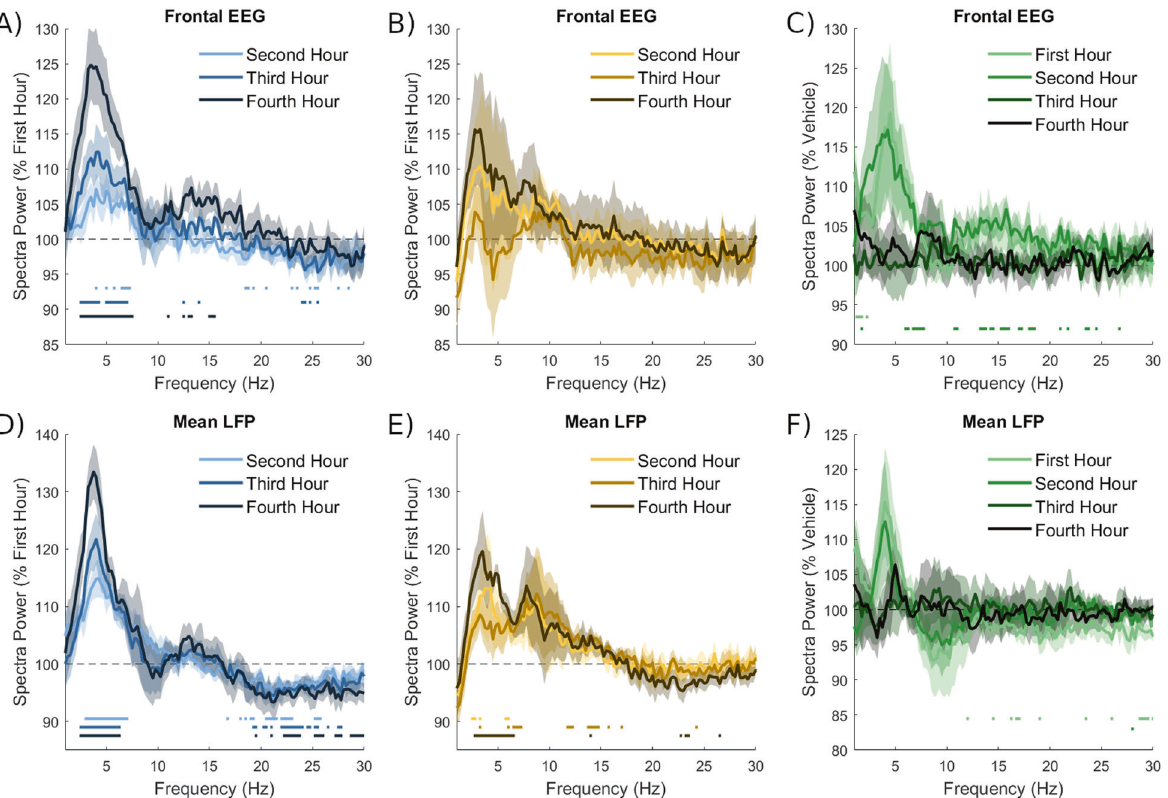
Fig. 8 The 3-5 Hz oscillation across sleep deprivation following vehicle and psilocin injection. The spectral power as a function of frequency across the 4 h of sleep deprivation, A ) in the frontal EEG in the vehicle and B ) psilocin condition. Values plotted are averages in the second, third and fourth hours as a percentage of average values in the fi rst hour. C ) Values plotted are averages in the four individual hours in the psilocin condition as a percentage of those in the corresponding hour in the vehicle condition. D, E, F ) show the same calculated for the mean LFP. Bold lines represent the mean and coloured ranges the standard error of the mean. Lines underneath the plots indicate discrete frequencies (at 0.25 Hz resolution) that were signi fi cantly different ( p < 0.05) from 100% according to a t